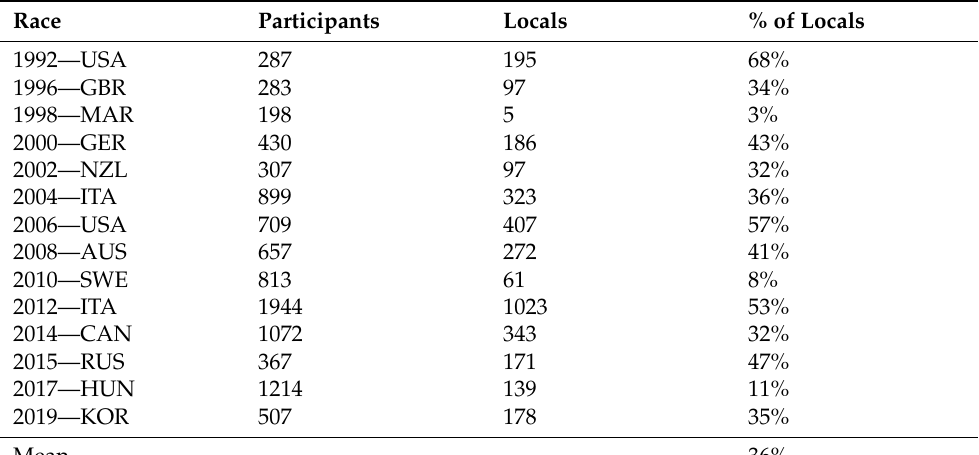
Table 3. Total number of participating athletes and local athletes in each one of the 3000 m open- water WC.